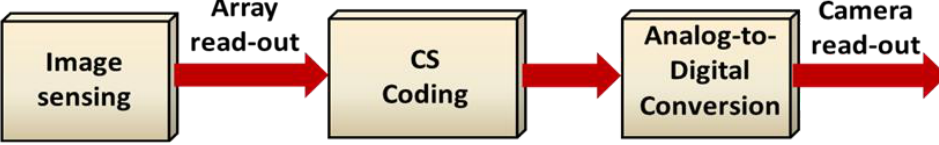
Figure 4. Block diagram for the analog implementation of CS